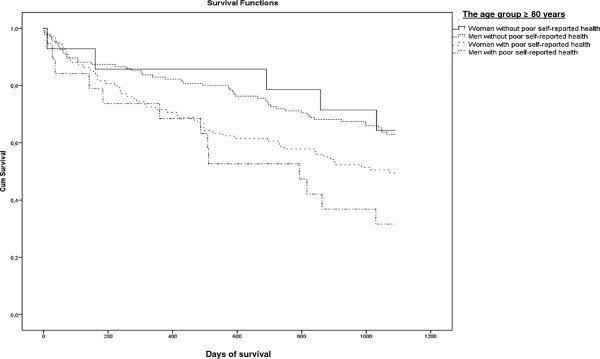
Kaplan-Meier plot: Days of Survival up to 3 Years (1096 days) in the Age group ≥ 80 years by Gender and with or without poor Self-reported Health.